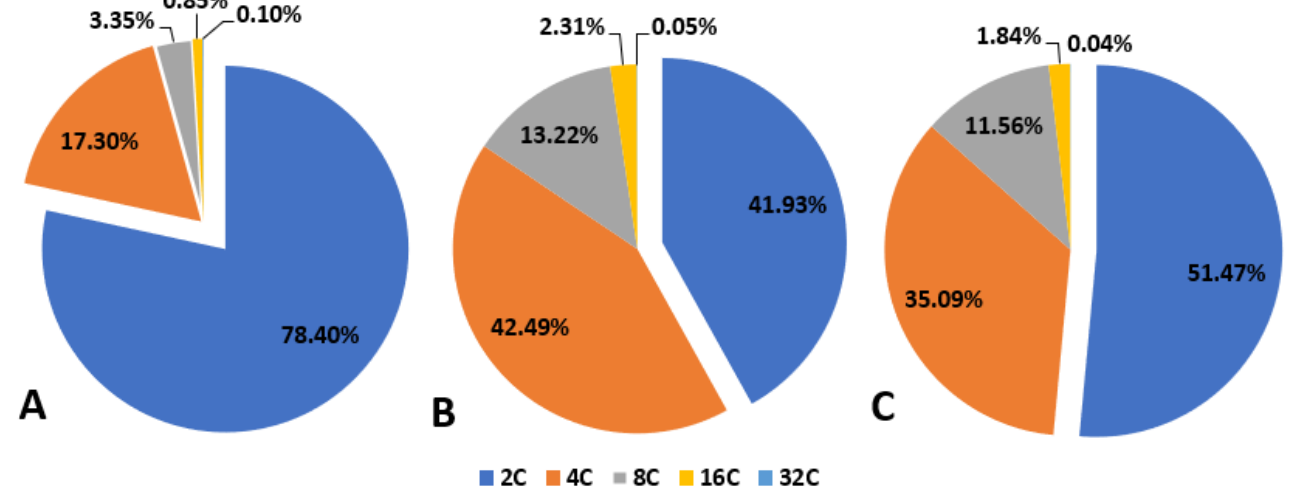
Figure 3. Frequency of nuclei with different DNA contents in various plant materials of Arabidopsis arenosa . Leaf (blade with petiole) of initial plants ( A ), 10–15-week-old callus on ½ MS supplemented with 2 mg L −1 2,4-D + 2 mg L −1 BAP ( B ), callus treated with 1 mg L −1 TDZ for 3 weeks ( C ). The ( Σ > 2C)/2C ratio was 0.292 [ ± 0.161], 2.559 [ ± 3.012], and 1.334 [ ± 1.452] for A , B , and C , respectively.